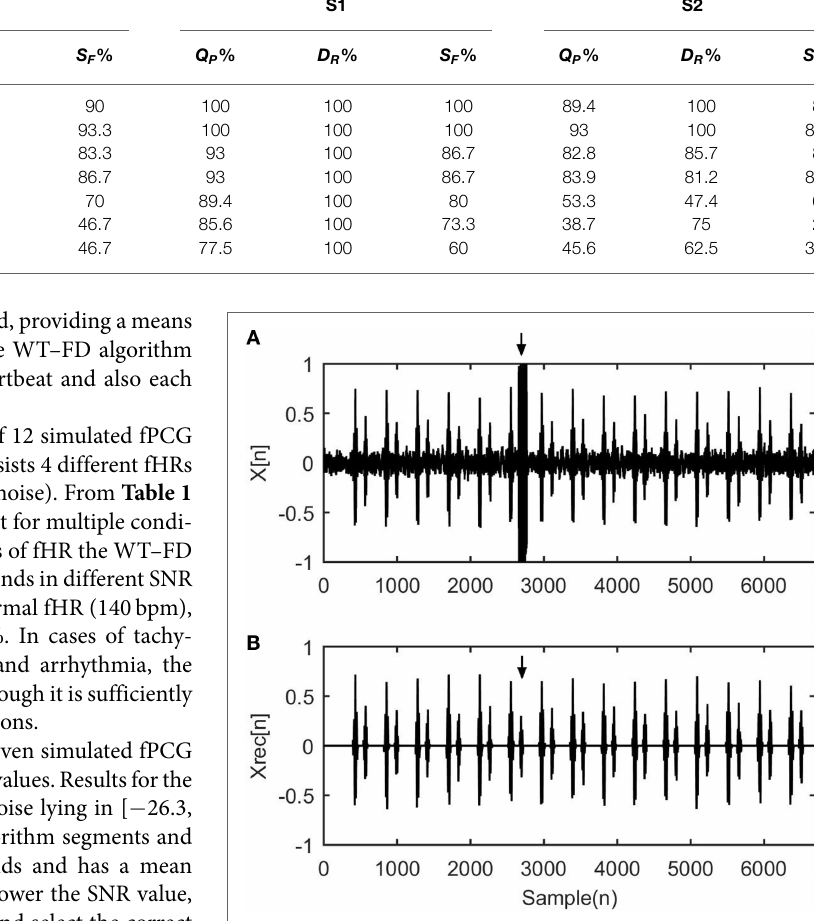
coefficients from the eight level WT decomposition. The WT–FD method selects these WT coefficients that include information (Eq. 9). For the real fPCG data processing, the constant of